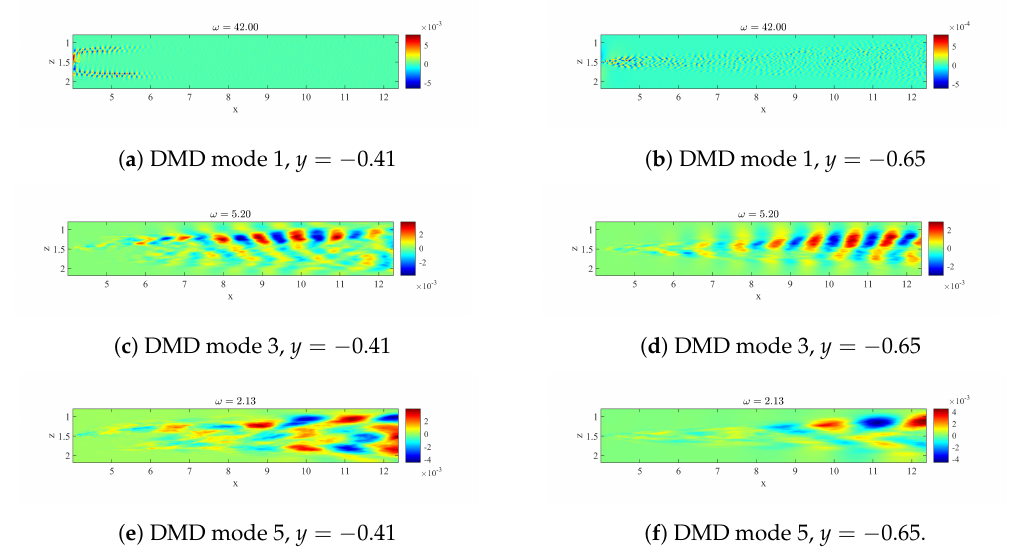
Figure 11. Streamwise velocity contours of the most relevant DMD modes on two y -constant planes.